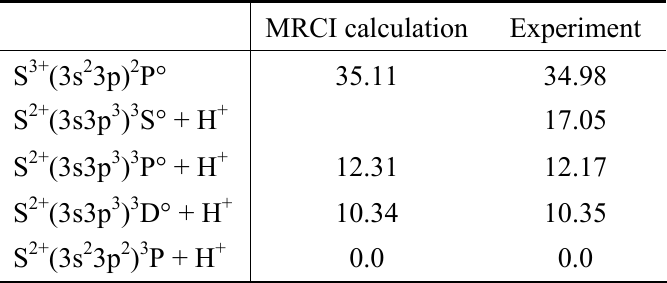
Table I: Comparison of atomic energy levels with experiment [17] (in